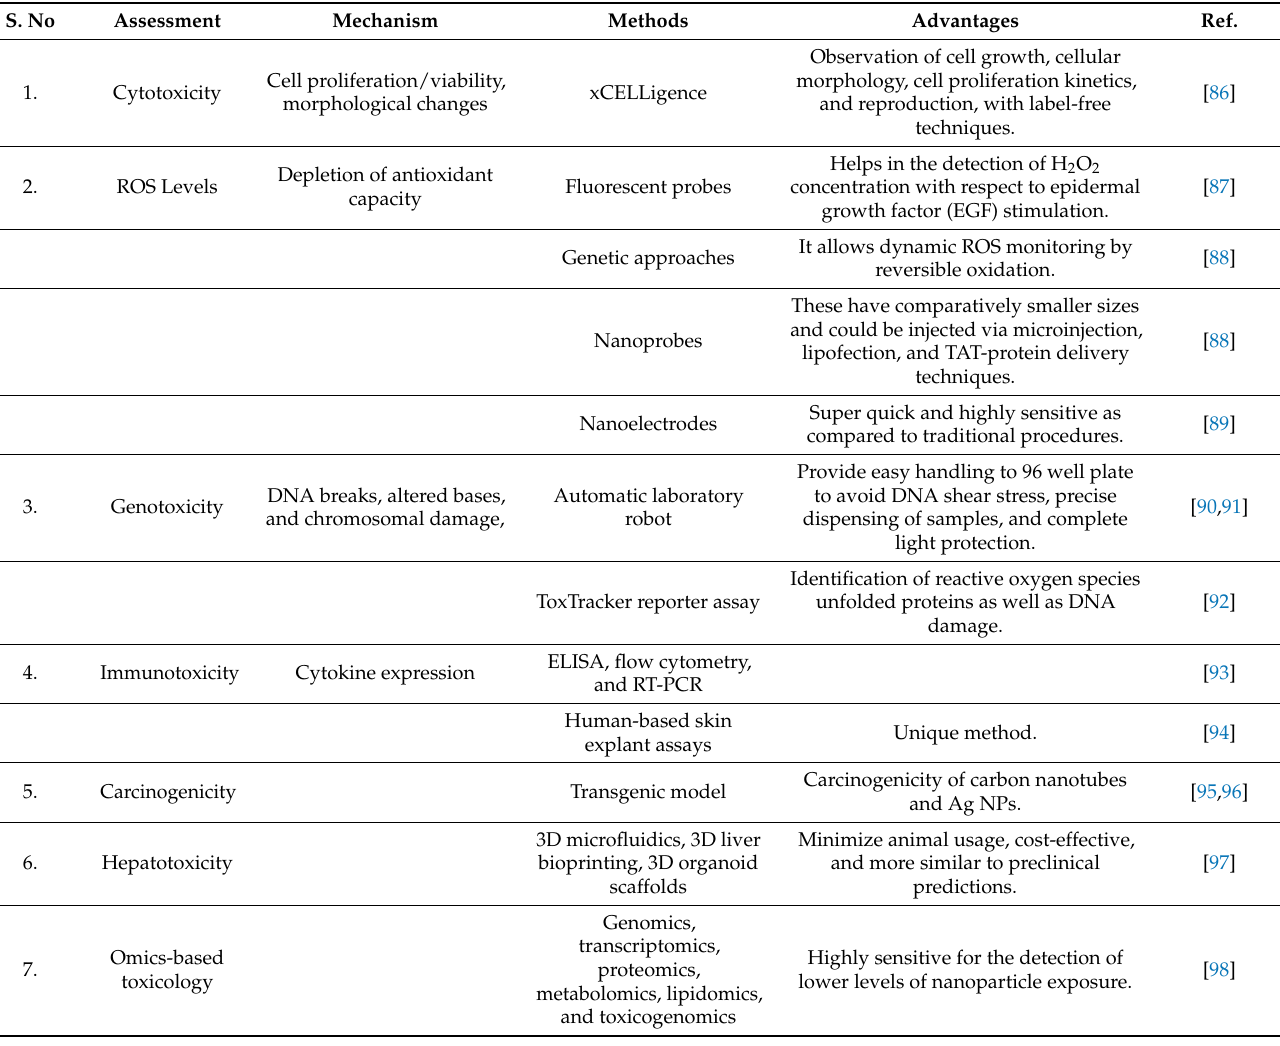
Table 2. Assessment of various safety and toxicity parameters with evaluation methods and their